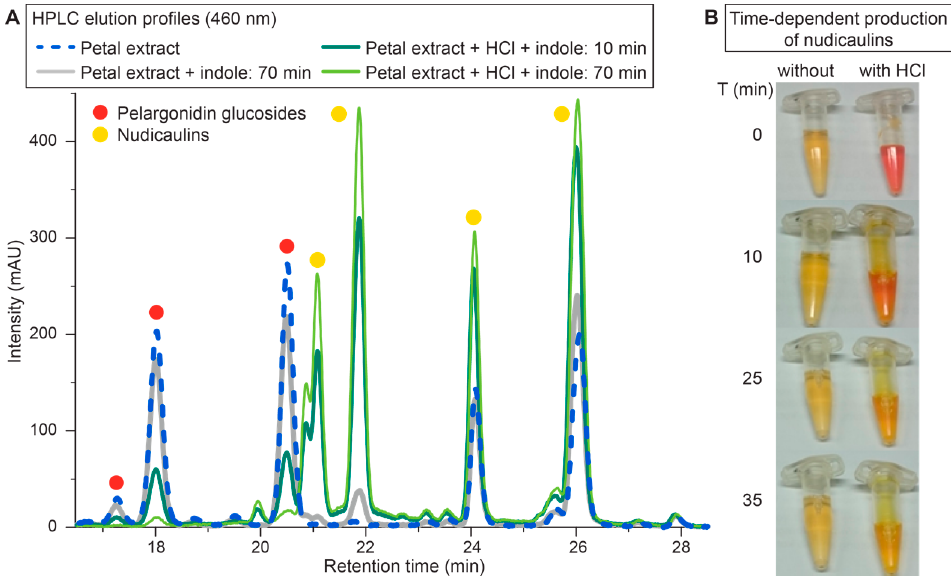
Figure 3. In vitro formation of nudicaulins in an extract of orange P. nudicaule petals supplemented with indole solution. ( A ) HPLC elution profile (460 nm, HPLC 1, method 2) of an extract without the addition of HCl (blue dotted line: 10 min; gray line: 70 min after indole addition) and after adding HCl (dark green line: 10 min; light green line: 70 min after indole addition), indicating the conversion of pelargonidin glucosides into nudicaulins. ( B ) Petal extracts without HCl: the color stays pale orange, indicating a mixture of pelargonidin glucosides and nudicaulins. Petal extracts with HCl: the color changes from bright orange (color of the pelargonidin flavylium cations and nudicaulins in mixture) to bright yellow, the color of nudicaulins.